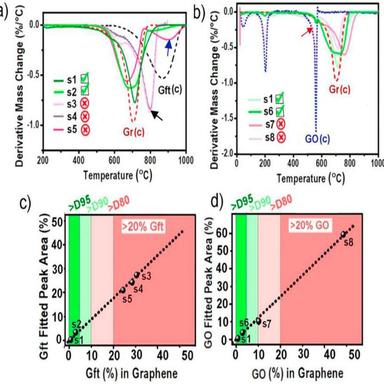
Characterization of industrially manufactured "graphene" powders. a-b) qualitative examination based on DTG signatures, peak shapes and peak positions (Tmax value) and c-d) quantitative determination of the percentage of graphite (c) and GO (d) components in tested graphene materials (S1-S8) with further details described in Table S3, Fig. S5 and Table S9. (A colour version of this figure can be viewed online.)